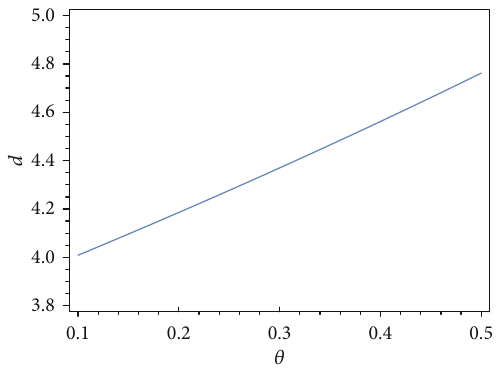
Figure 2: Sensitivity of d ∗ with respect to θ